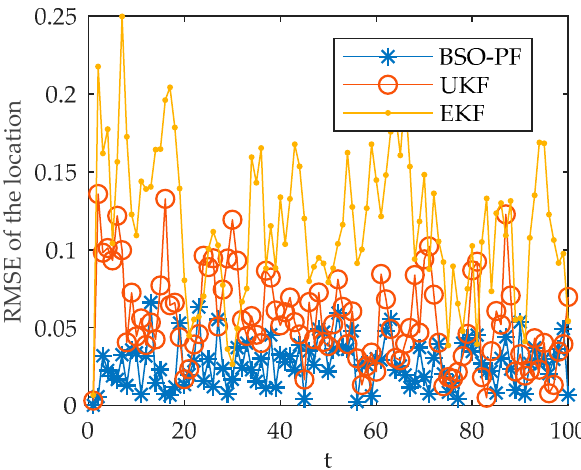
Figure 5. Algorithm comparison chart.